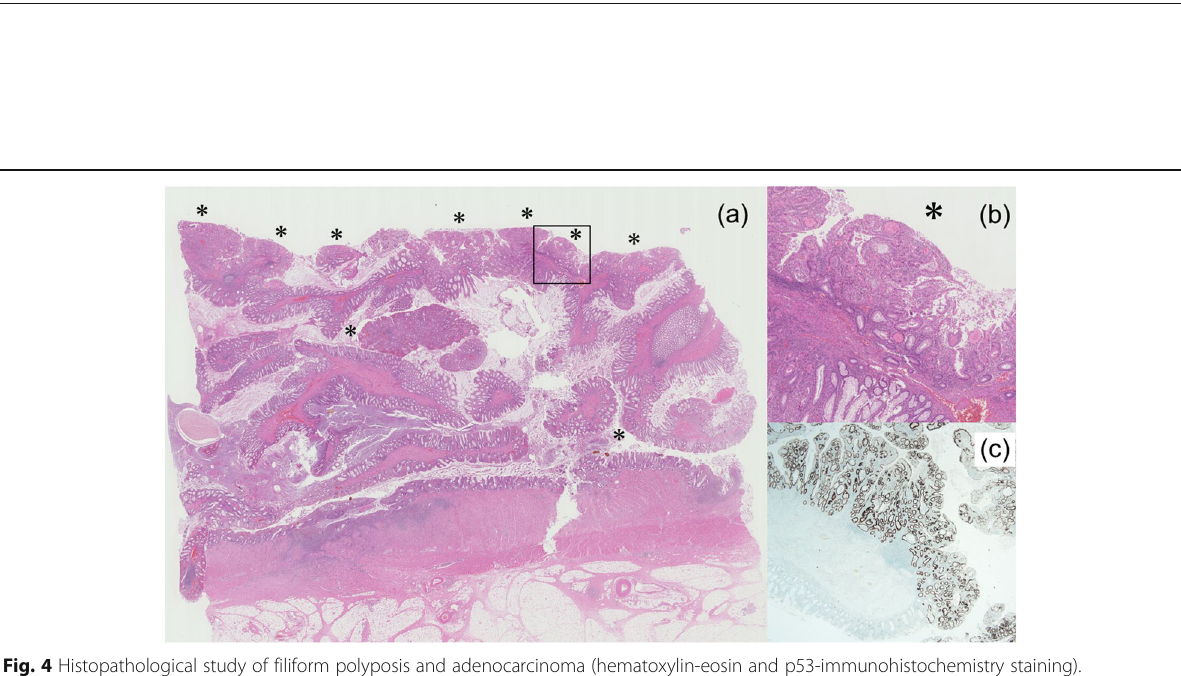
Fig. 3 Macroscopic study of the surgical specimen after formalin fixation. Sigmoidectomy specimen showed a tumor measuring 110 × 95 mm; it had a coral-reef-like surface and with numerous soft, worm-like polyps. A solid 30-mm mass, surrounded by these polyps, developed on the anterior wall of the sigmoid colon (white arrowhead). a A solid mass did not spread to the serosa (white arrowhead). The anterior wall was thickened with several diverticulitis (black arrow). b – d The tumor was almost constituted with numerous soft, worm-like polyps. Histopathological findings of these polyps are shown in Fig. 4